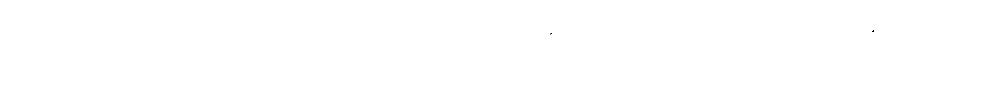
TABLE V: Total distance scores expressed as the percentage of incorrect features: Mrs